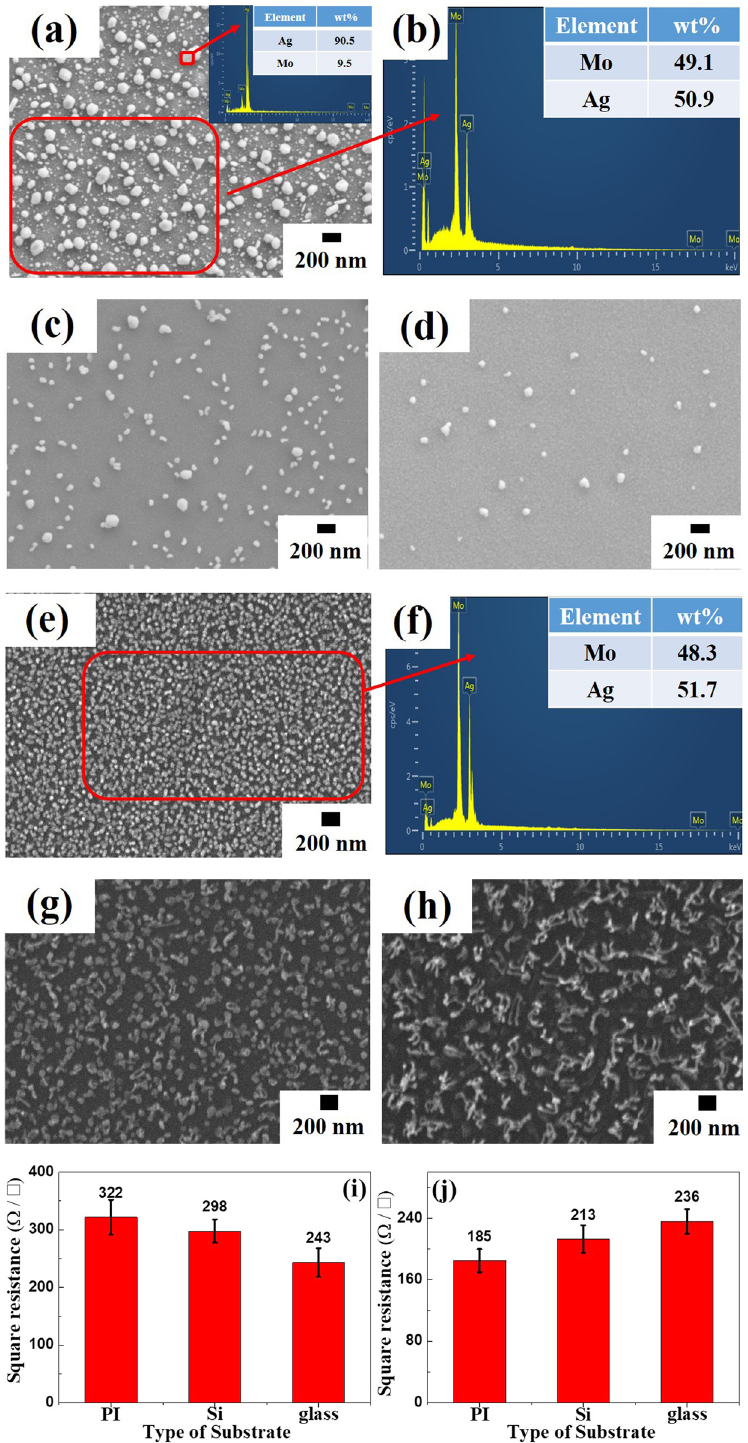
Figure 3: Surface morphology of Ag – Mo alloy fi lms annealed at 360°C on di ff erent substrates by composite target sputtering: ( a ) PI substrate, ( b ) EDS pattern of ( a ) , ( c ) Si substrate, ( d ) glass substrate. surface morphology of the Ag – Mo alloy fi lms annealed at 360°C on di ff erent substrates by co - sputtering: ( e ) PI substrate, ( f ) EDS pattern of ( e ) , ( g ) Si substrate, ( h ) glass substrate; ( i ) square resistance of Ag – Mo fi lms prepared by composite target sputtering, and ( j ) square resistance of Ag – Mo fi lms prepared by co -